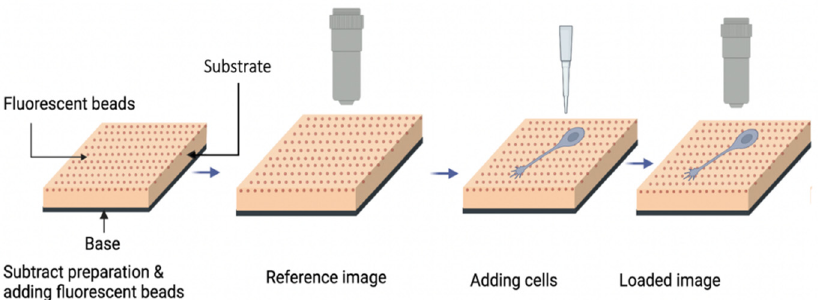
Figure 2. Schematic of the basic procedures used in traction force microscopy (detailed description given in the main text).